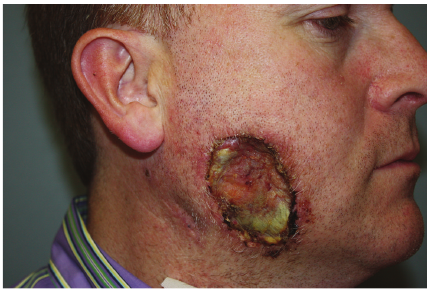
Figure 3: Case 4 shows 6cm diameter right cheek defect after melanoma resection with split thickness skin graft closure.